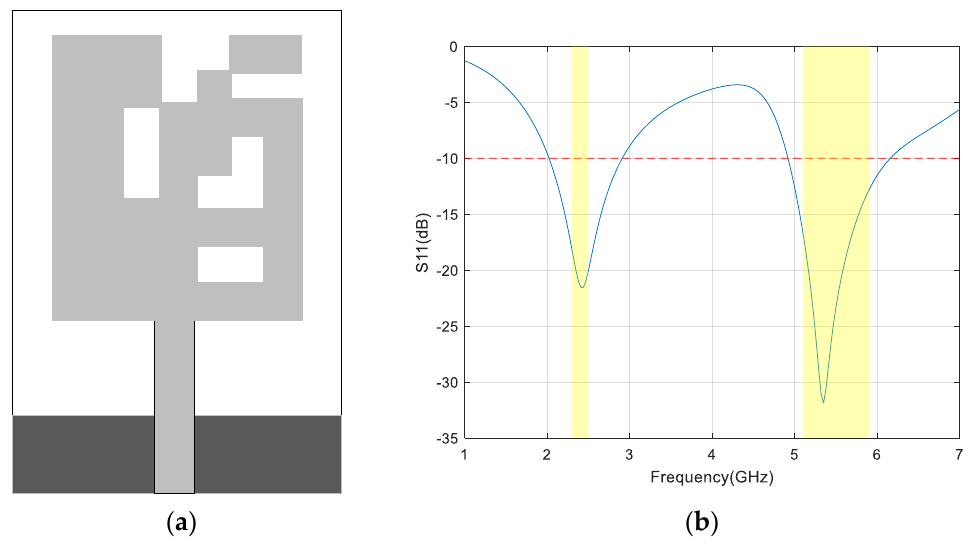
Figure 10. Final geometry ( a ) and S 11 curve ( b ) of the final antenna.